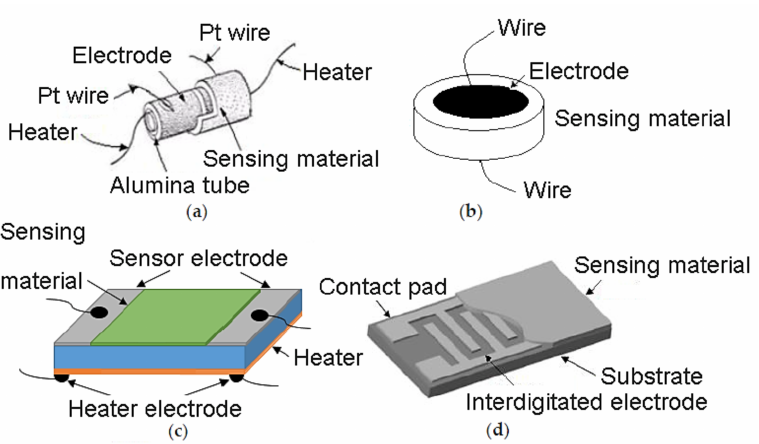
Figure 3. Various configurations of electrodes being used for chemiresistive gas sensors. ( a ) Cylindri- cal; ( b ) disk-type; ( c ) planar contacts; ( d ) inter-digitated electrode. Elaboration from reference [22]. Reprinted with permission under CC